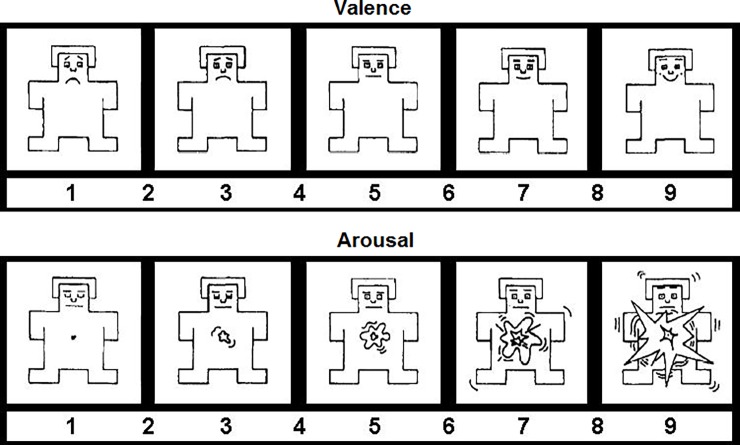
The valence and arousal rating scales of the Self-Assessment Manikin.